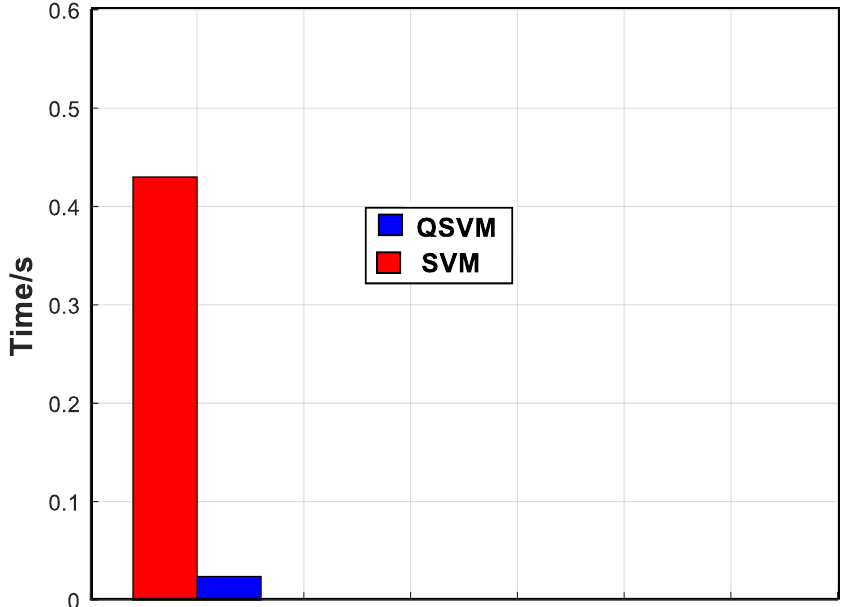
Figure 2. QSVM vs. SVM performance comparison: accuracy, precision, and recall parameters.